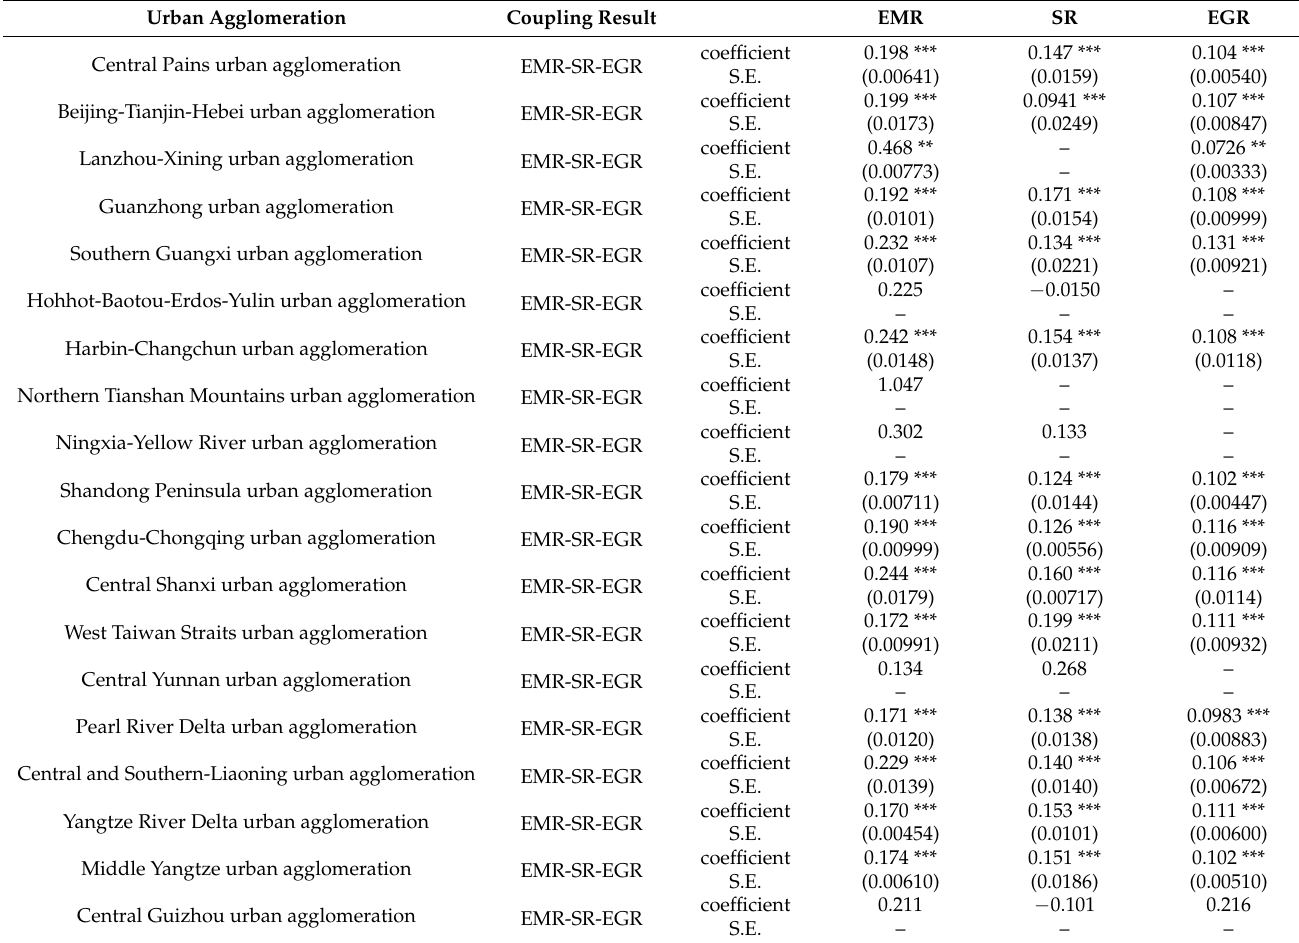
Table 2. Fixed-effects model regression